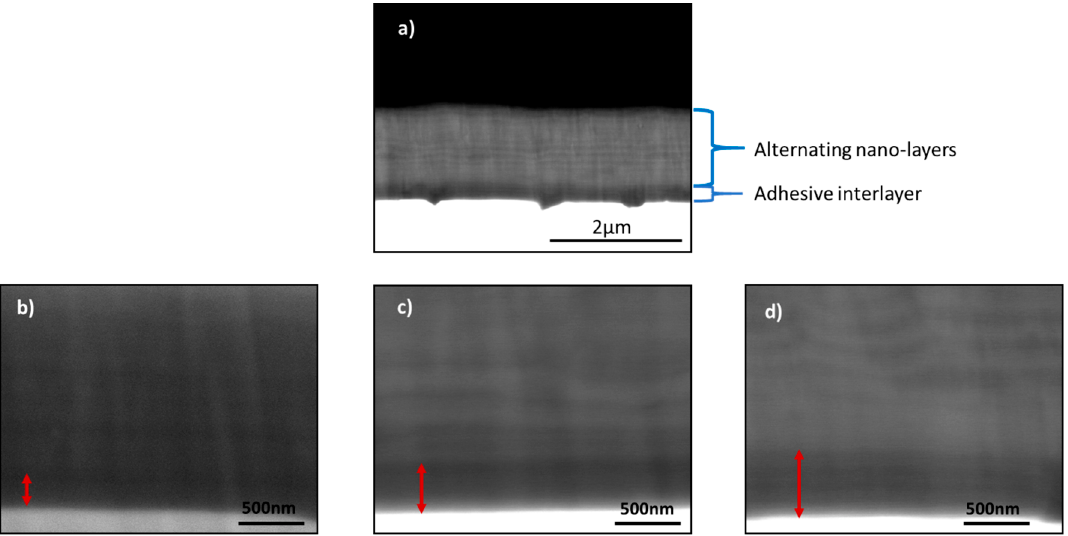
Figure 4. SEM images of the focused ion beam (FIB) cross-section showing ( a ) alternating nano-layers, the interlayer in the studied multilayer coatings, and the variation of interlayer thickness ( b ) (100 ± 30 nm), ( c ) (300 ± 30 nm), and ( d ) (500 ± 30 nm).